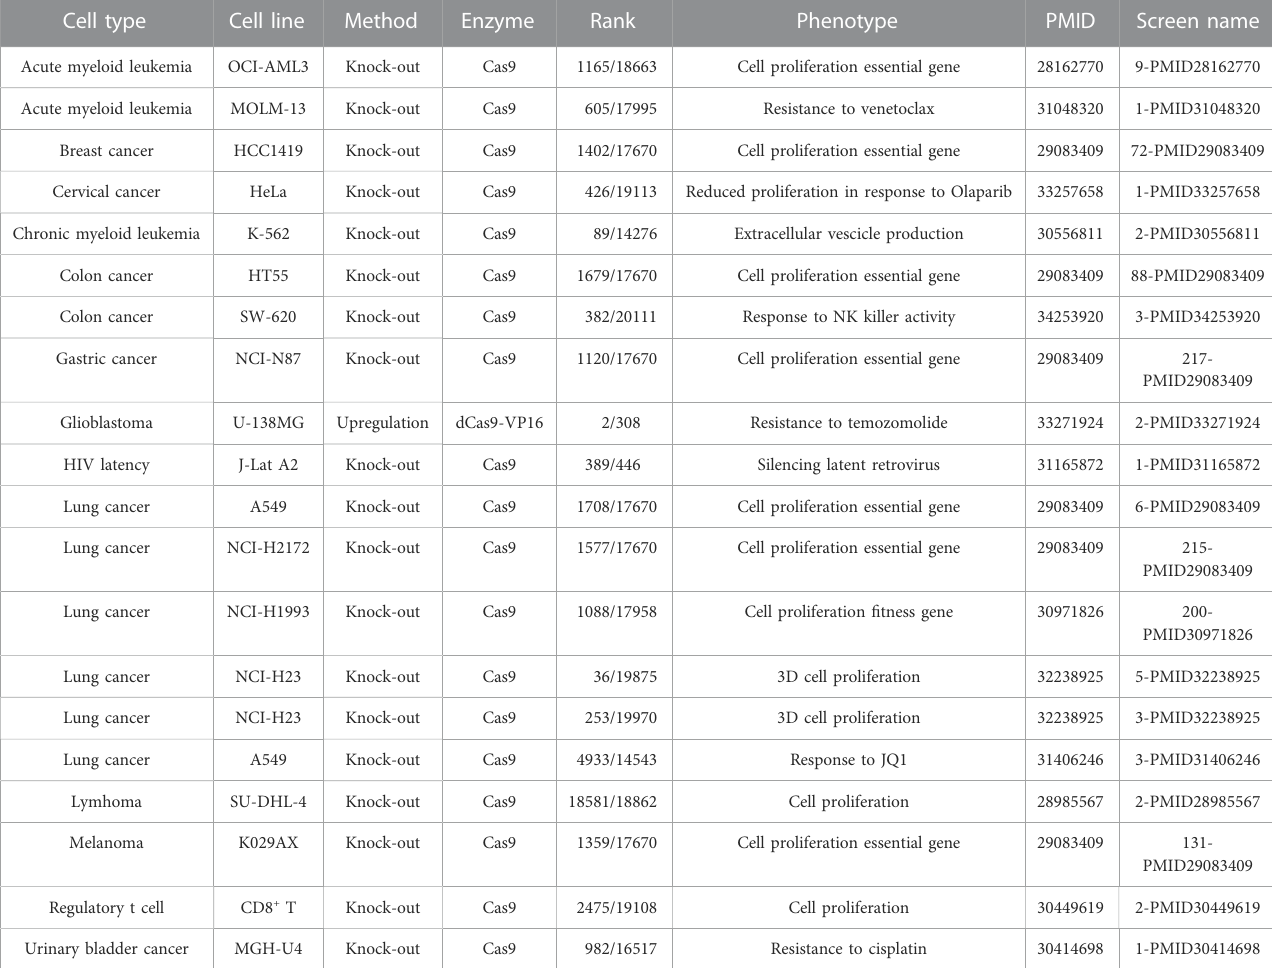
TABLE 3HDAC4isrequired for theproliferation andsurvivalofdifferent cancer cells.Data ofCRISPR screensandrelativeinformation wereretrievedfrom theBioGRID ORCS open repository https://orcs.thebiogrid.org. Cell